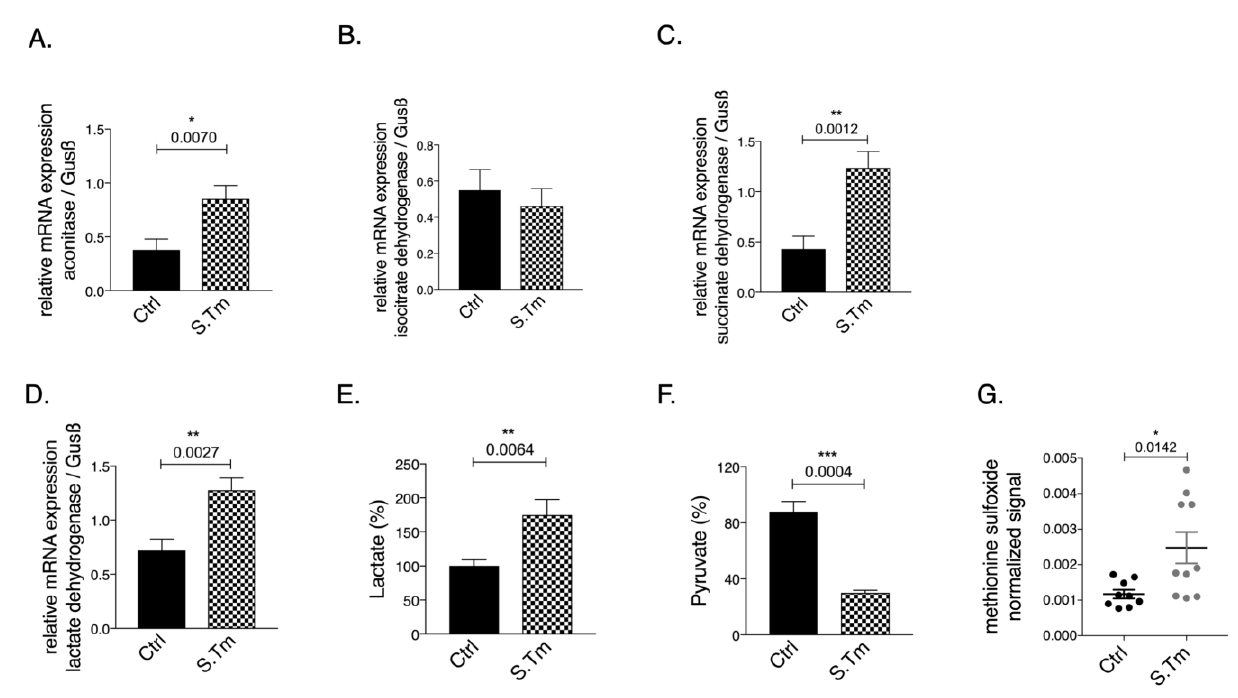
FIGURE 2: Effects of Salmonella infection on the expression of metabolic enzymes and metabolites in RAW264.7 macrophages. Cells were infected with Salmonella enterica serovar Thyphimurium (MOI of 10) as detailed in methods. Expression of aconitase (A) , isocitrate dehy- drogenase (B) , succinate dehydrogenase (C) and lactate dehydrogenase (D) mRNA relative to the house keeping gene was determined by qRT-PCR in untreated control cells (ctrl) or infected cells after 24 hours. Pyruvate, lactate and methionine sulfoxide levels (E-G) were deter- mined in cell culture supernatants. Representative data from two independent experiments performed with 3 and 6 replicates are shown. Graphs show means ± SEM. Student’s t -test was used. Exact p-values are indicated in the